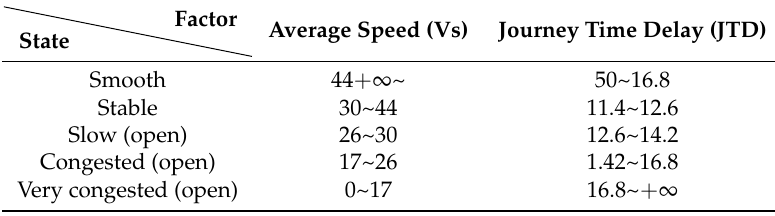
Figure 7. Results of the improved FCM clustering analysis for the standard range. Table 1. Fuzzy standard ranges of influential factors in different states of the specific gated community